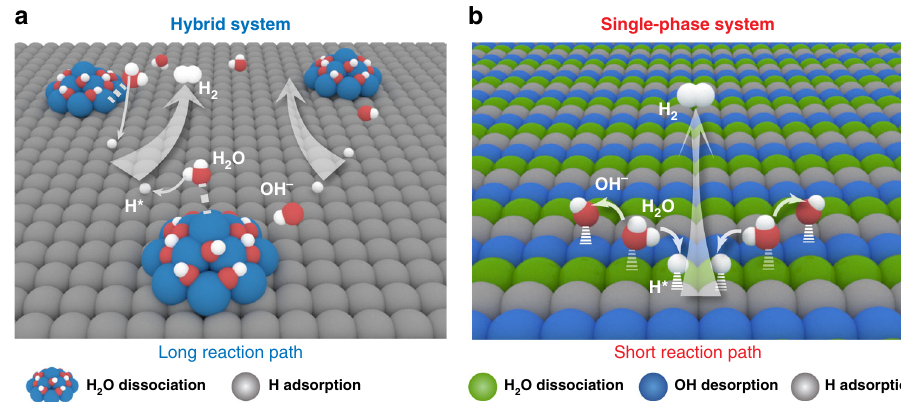
Fig. 1 Schematic description of the reaction pathways on two-type synergistic catalysts for alkaline HER electrocatalysis. a The conventional hybrid system by coupling noble metals with metal (hydro)oxides. b The conductive single-phase system with intrinsically atomic-scale synergistic active